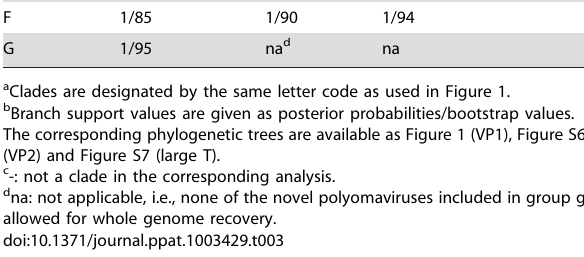
a Clades are designated by the same letter code as used in Figure 1. b Branch support values are given as posterior probabilities/bootstrap values. The corresponding phylogenetic trees are available as Figure 1 (VP1), Figure S6 (VP2) and Figure S7 (large T). c -: not a clade in the corresponding analysis. d na: not applicable, i.e., none of the novel polyomaviruses included in group